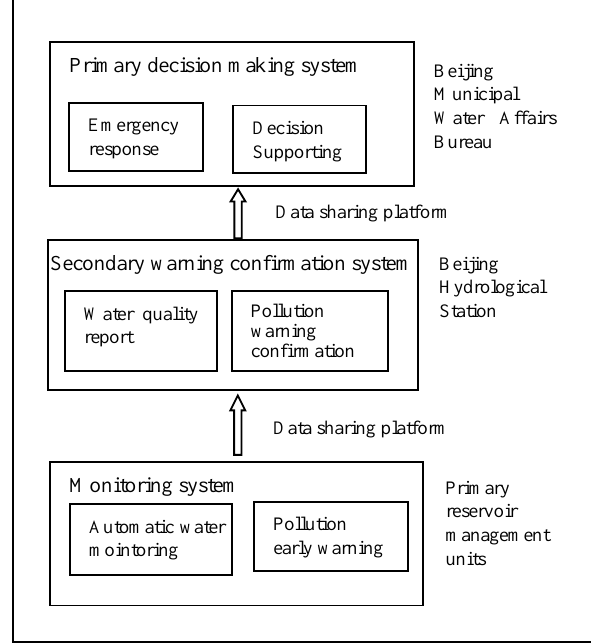
Figure 2. Pollution warning and response platform